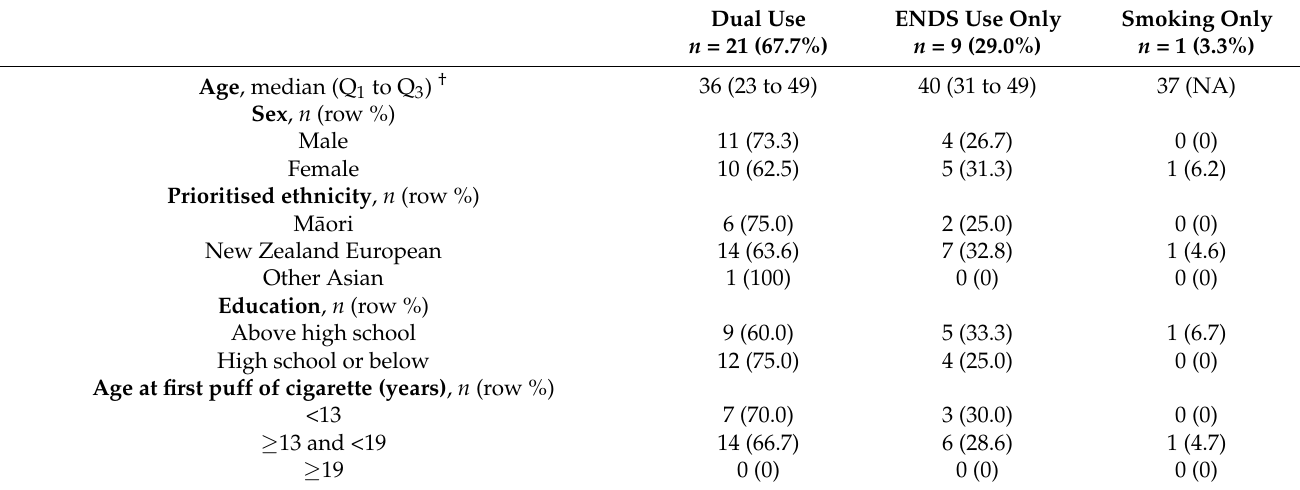
Table 2. Baseline characteristics of the participants included in the transition classification analysis ( n = 31) *, based on their transition classification after 12 weeks of study